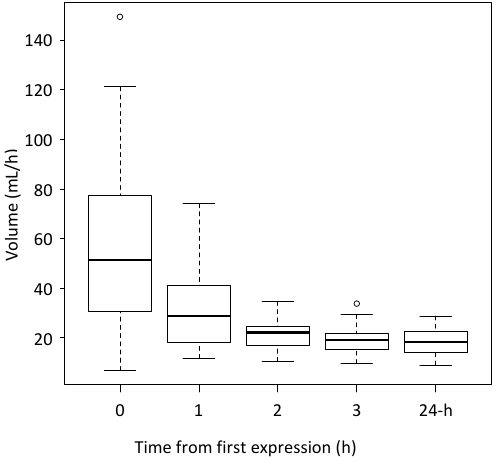
Figure 1. The yield of milk from hourly expressions, and the hourly rate of milk synthesis calculated from the 24-h milk profile data (24-h). n = 29 breasts.